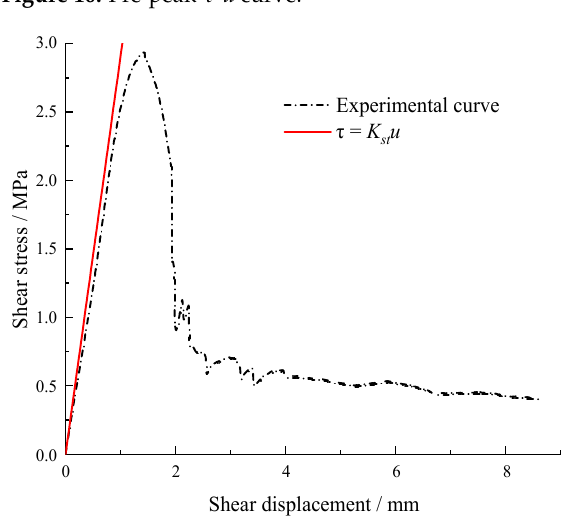
Figure 10. Pre-peak τ - u curve.